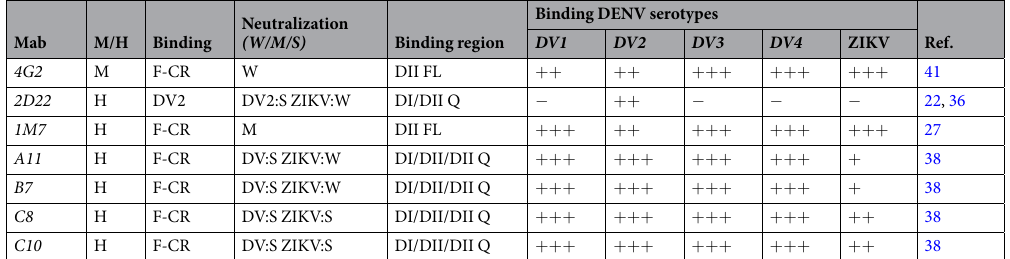
Neutralization (W/M/S)